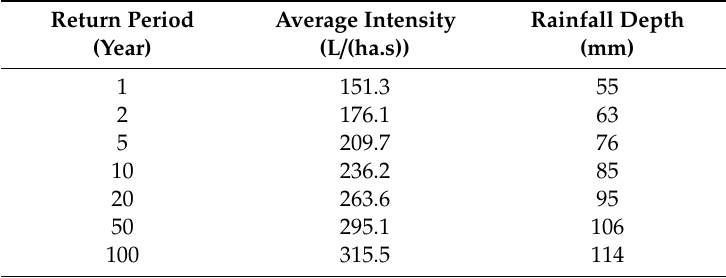
Figure 2. The location of the study area in Guangzhou, China ( a ), its topography and aerial image ( b ), and 25 independent drainage networks ( c ). The location of the monitoring system is marked by a red pentagram in the drainage network DN25. Table 1. Average intensity and rainfall depth for design storms with typical return periods over a 1 h duration in Guangzhou,